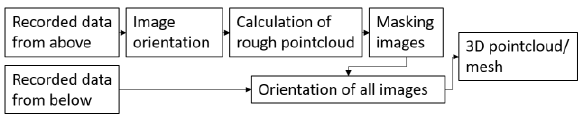
Figure 6. Processing workflow in Agisoft